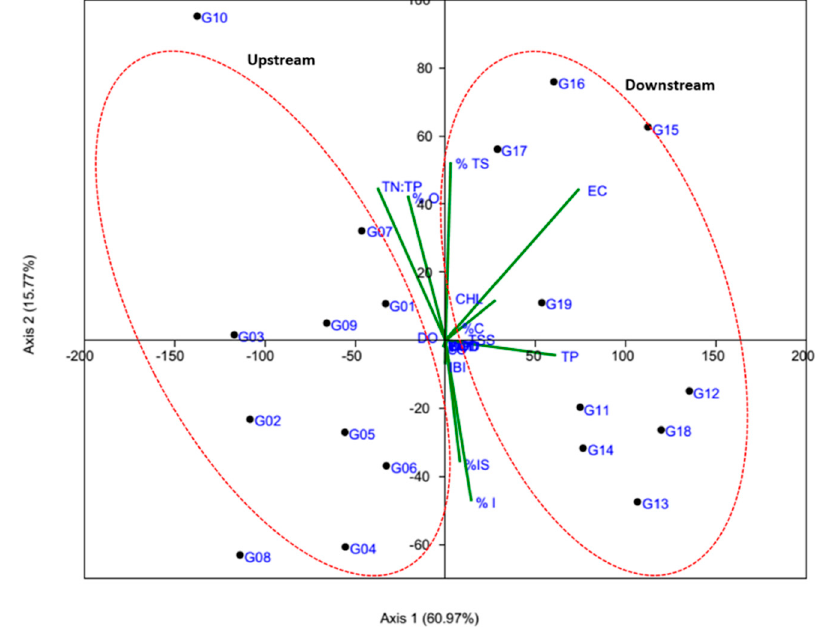
Figure 12. Principal component analysis based on water quality factors and fish guilds. TN—total